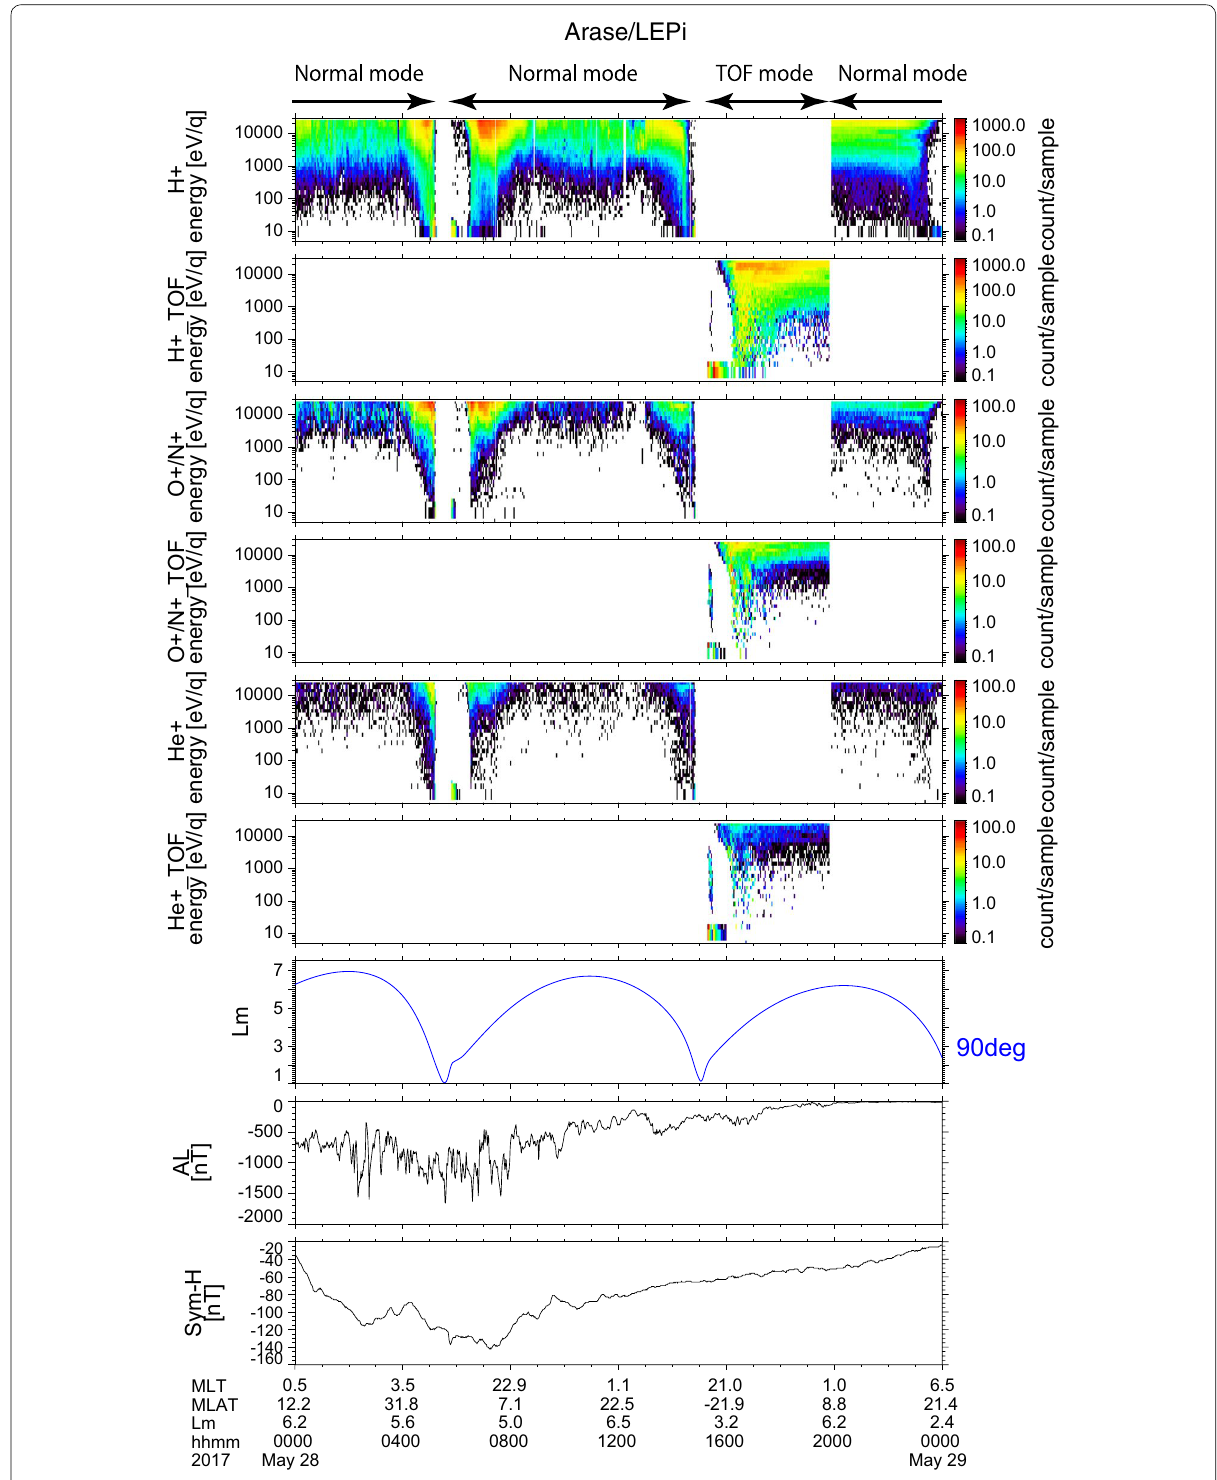
Fig. 15 Energy–time diagram of the count rate of H + , O + / N + , and He + observed by LEPi on May 28, 2017. Lm, AL, and Sym-H indices are also shown. AL and Sym-H indices indicate the strongest current intensity of westward auroral electrojets and a measure of geomagnetic disturbance,